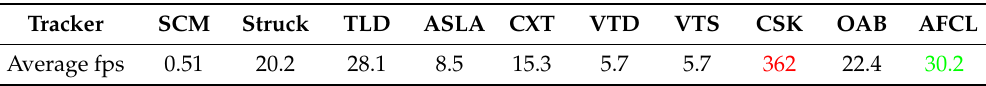
Table 3. Speeds and implementations of the tracking methods. fps, frames per second the best results are in red and the second best results are in